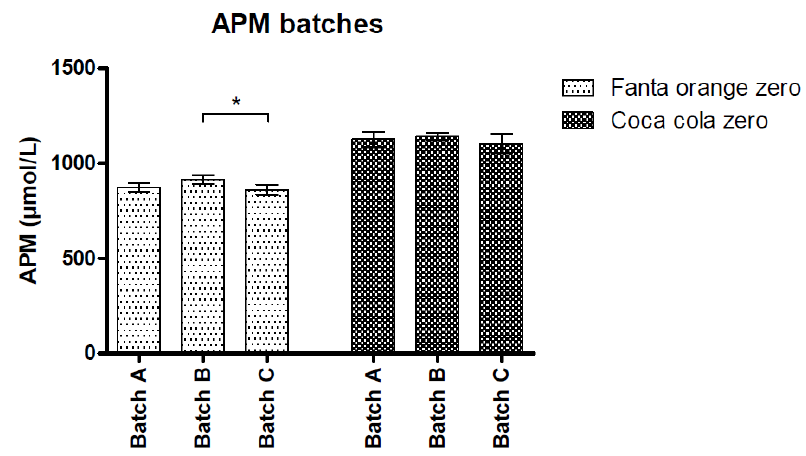
Figure 2. Between-batch variation of aspartame and total phenylalanine concentrations for Fanta orange zero and Coca cola zero sugar; * p -value < 0.05. Data represent mean ± SD.